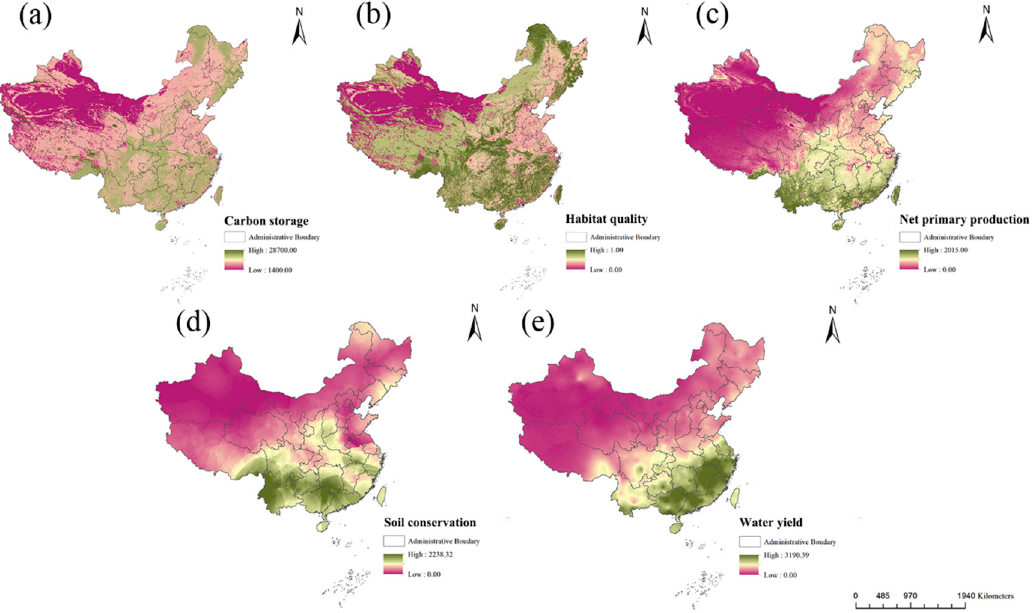
Figure 2. Spatial distribution of the carbon storage ( a ), habitat quality ( b ), net primary production ( c ), soil conservation ( d ), and water yield ( e ) services in China.